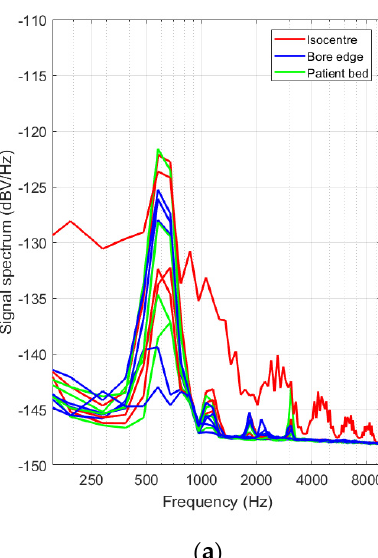
are grouped according to their respective test location, indicated by different colors: scanner isocen- ter (red solid line), end of the bore on the patient bed (green) and right next to the scanner bore opening (blue). ( b ) Amplitude spectra acquired for signals acquired on the second experimental campaign. Color coding is identical as in panel ( a ).